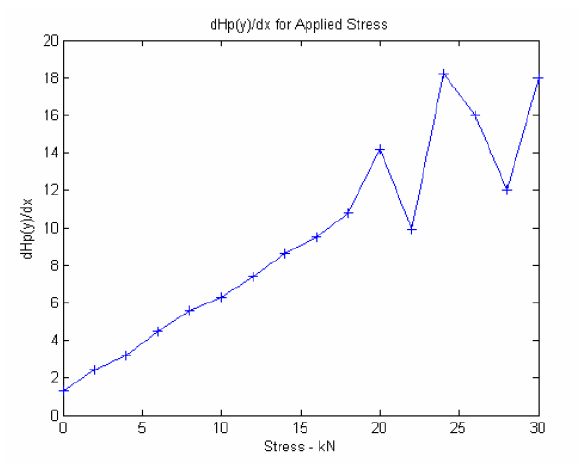
Figure 1. dHp(y)/dx for applied tensile stress on a steel sample [18]; see the linear dependence in the elastic